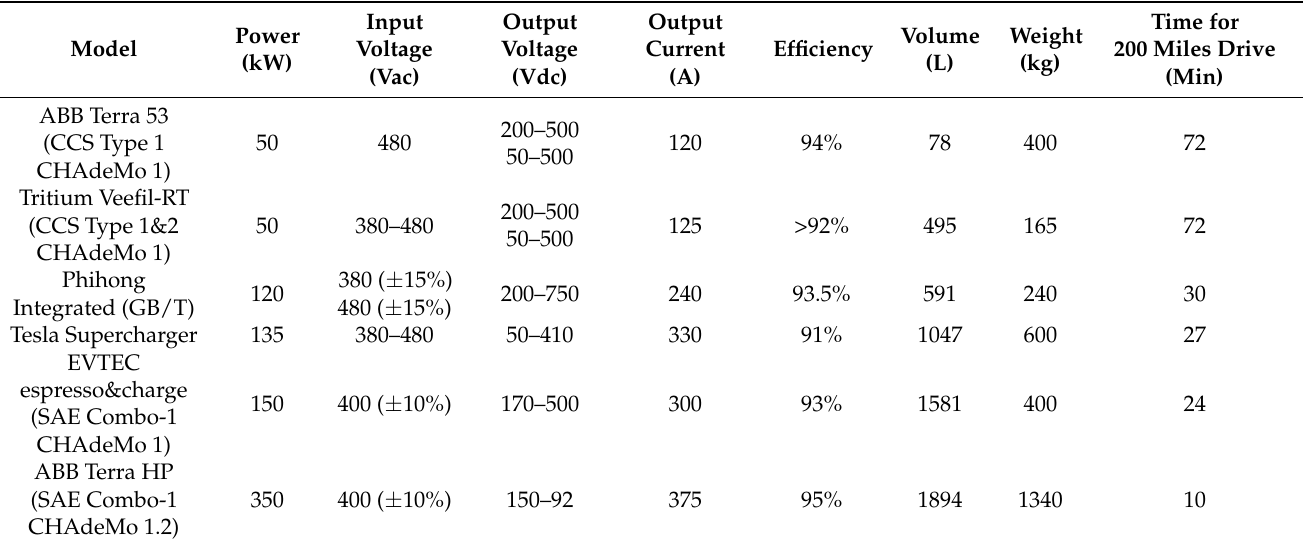
Table 1. Technical specifications of the state-of-the-art DCFCs (Reprinted with permission from Ref. [6]. Copyright 2019